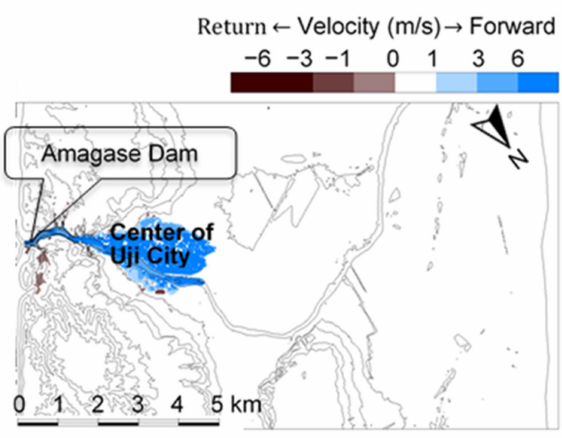
Figure 17. (Case–1). Inundation velocity, 10 min after the start of the calculation.